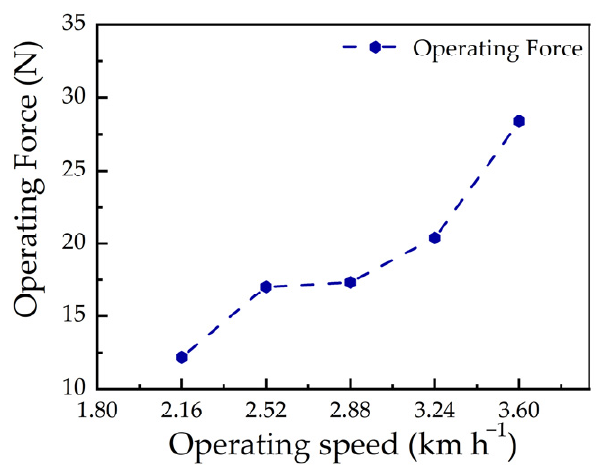
Figure 6. Relationship between operating speed and furrowing resistance. Analysis of Furrowing Resistance at Different Speeds